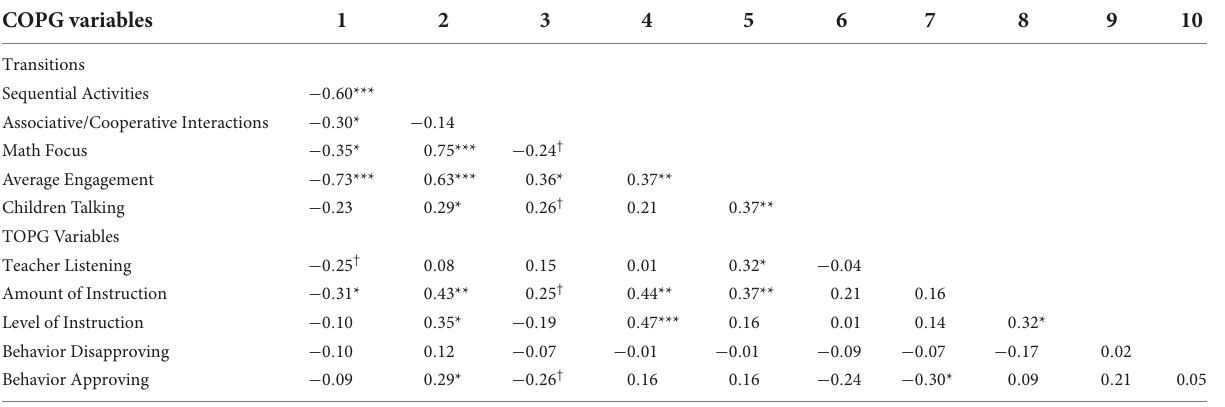
TABLE 3 Correlations among indicators of the key classroom practices.